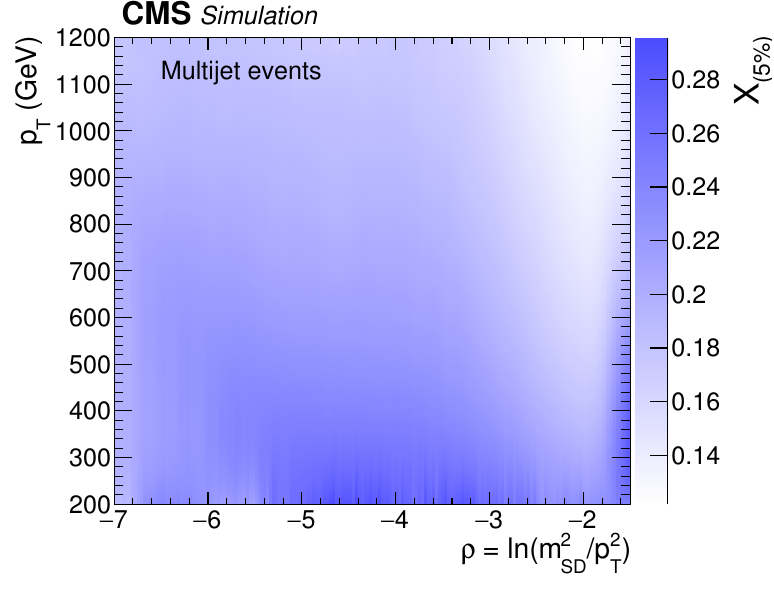
Figure 2 . The distribution of X used to de(cid:12)ne the N 1 ; DDT variable, corresponding to the (5%) 2 5% quantile of the N 1 distribution in simulated multijet events. The distribution is shown as a 2 function of the jet (cid:26) and p T and smoothed using a kNN approach [64]. The N 1 distribution is 2 mostly insensitive to the jet (cid:26) and p T in the kinematic phase space considered for this analysis ( (cid:0) 5 : 5 < (cid:26) < (cid:0) 2 : 0). Residual correlations in simulation are corrected by applying a decorrelation procedure that yields the N 1 ; DDT 2